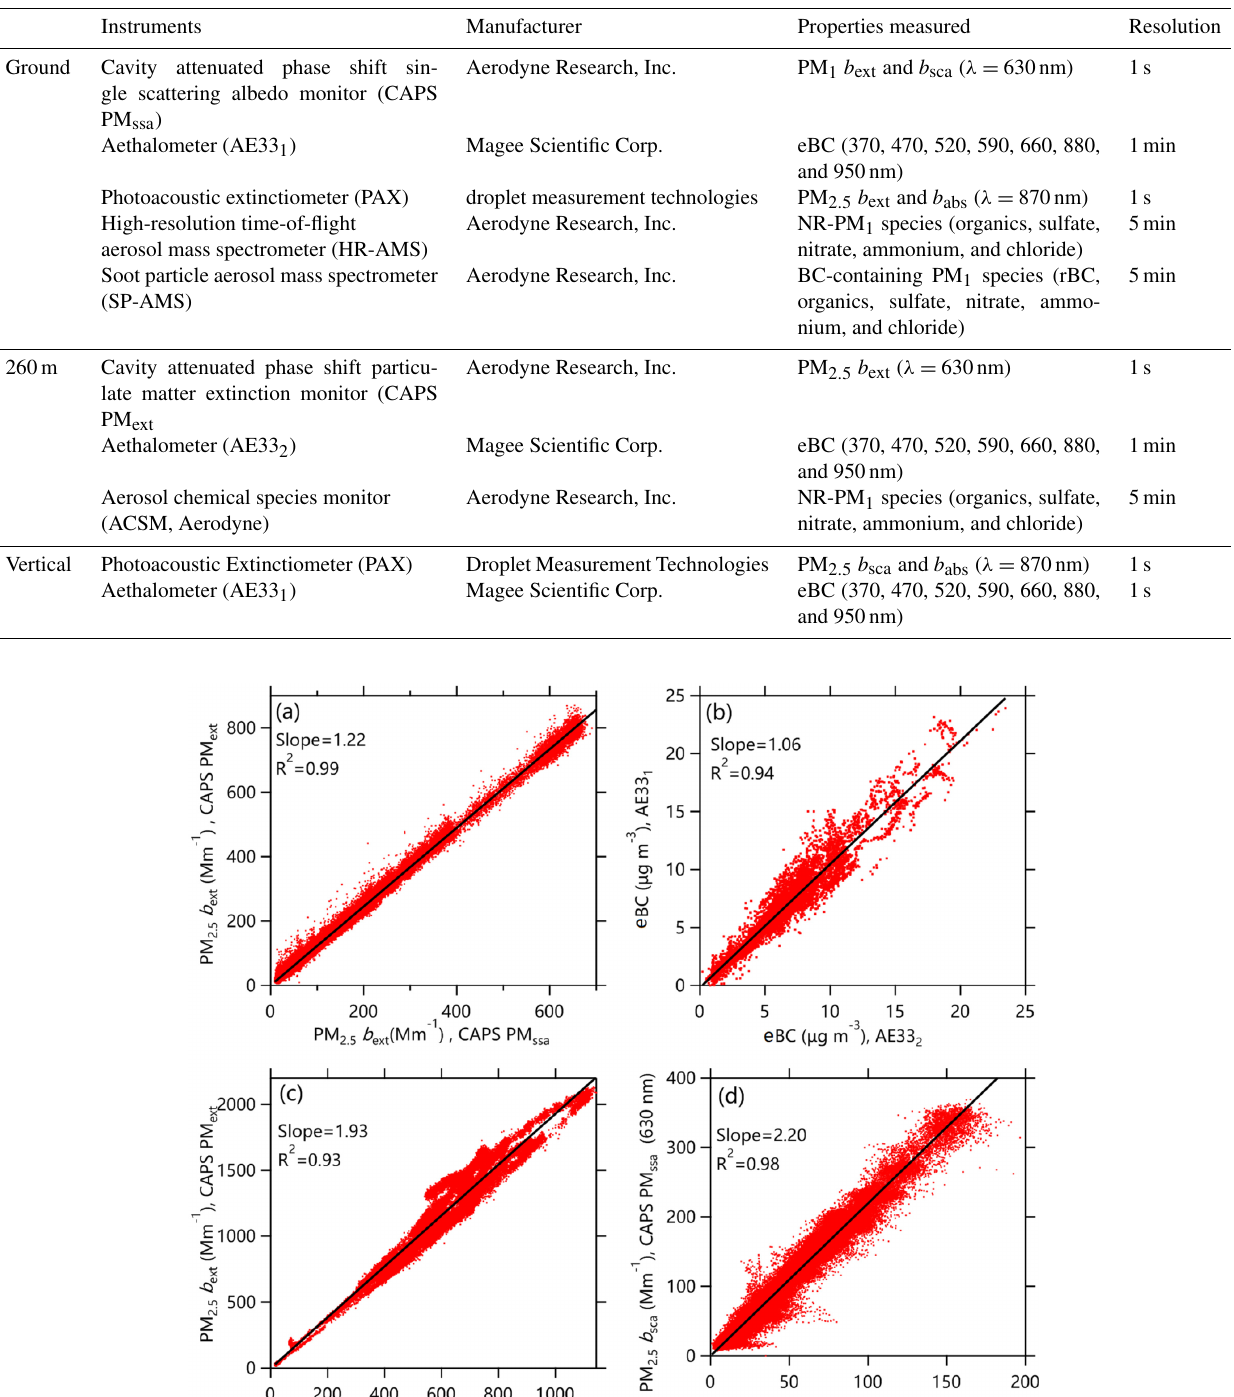
Table 1. A summary of measurements in this study.